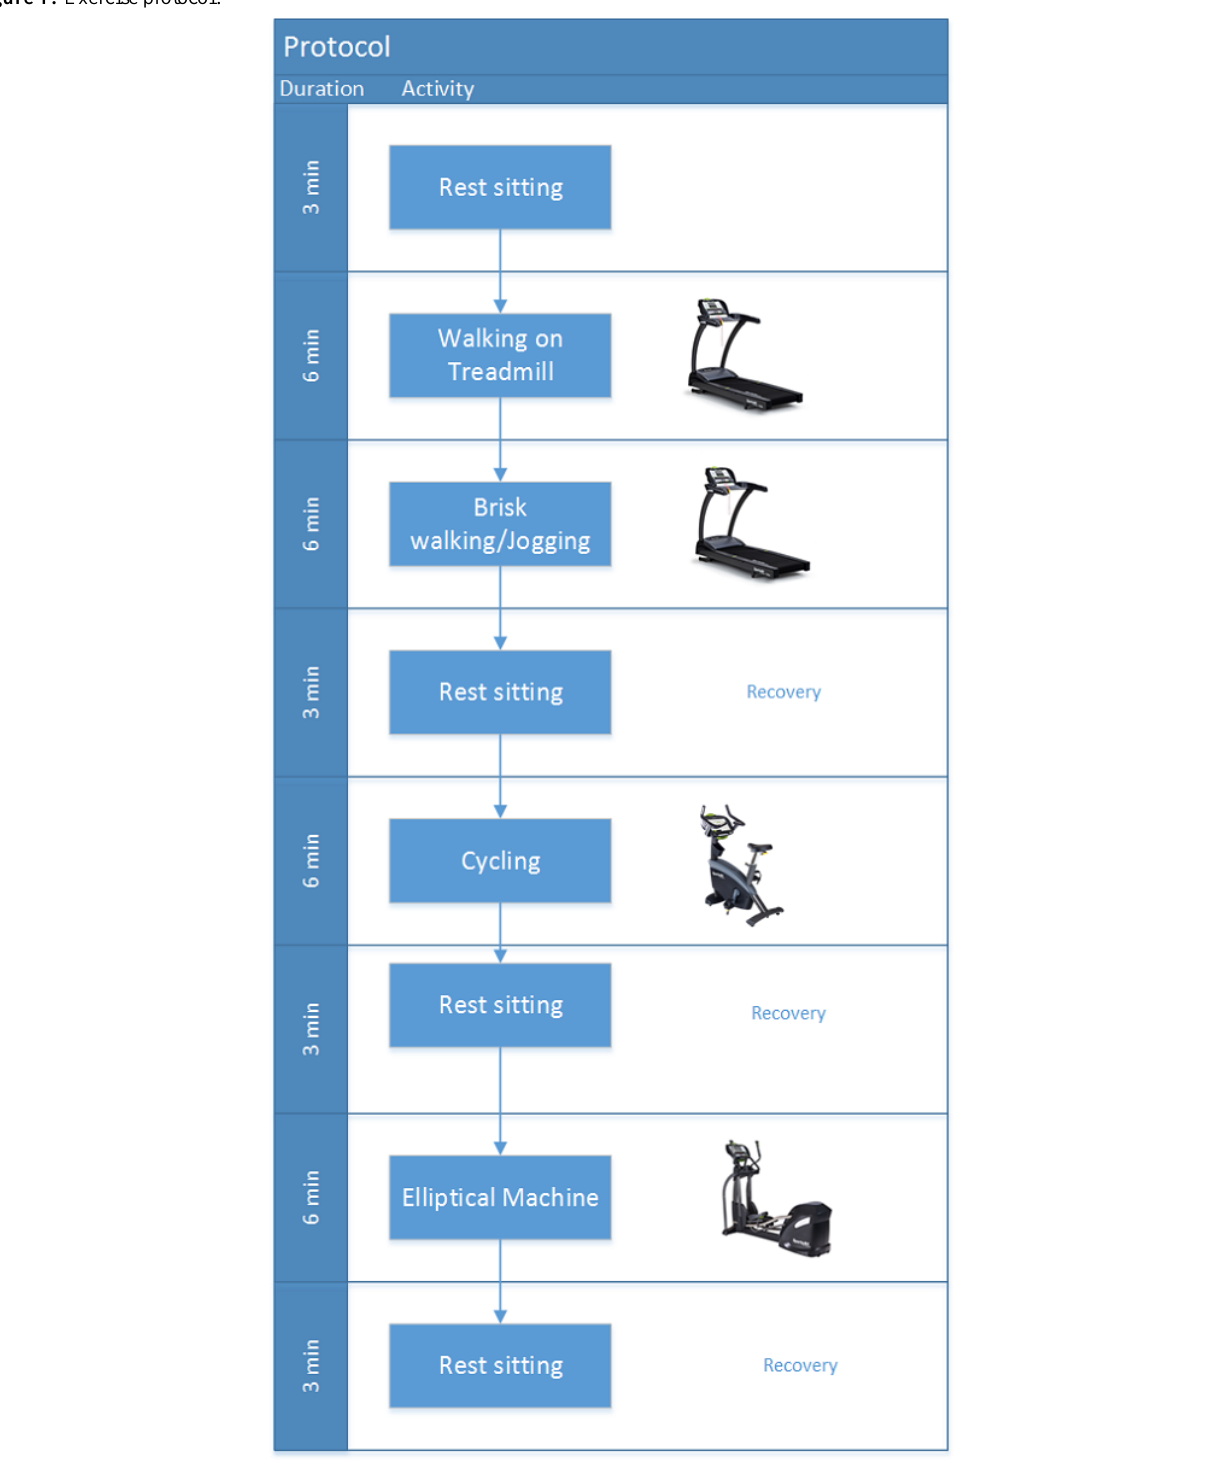
Figure 1. Exercise